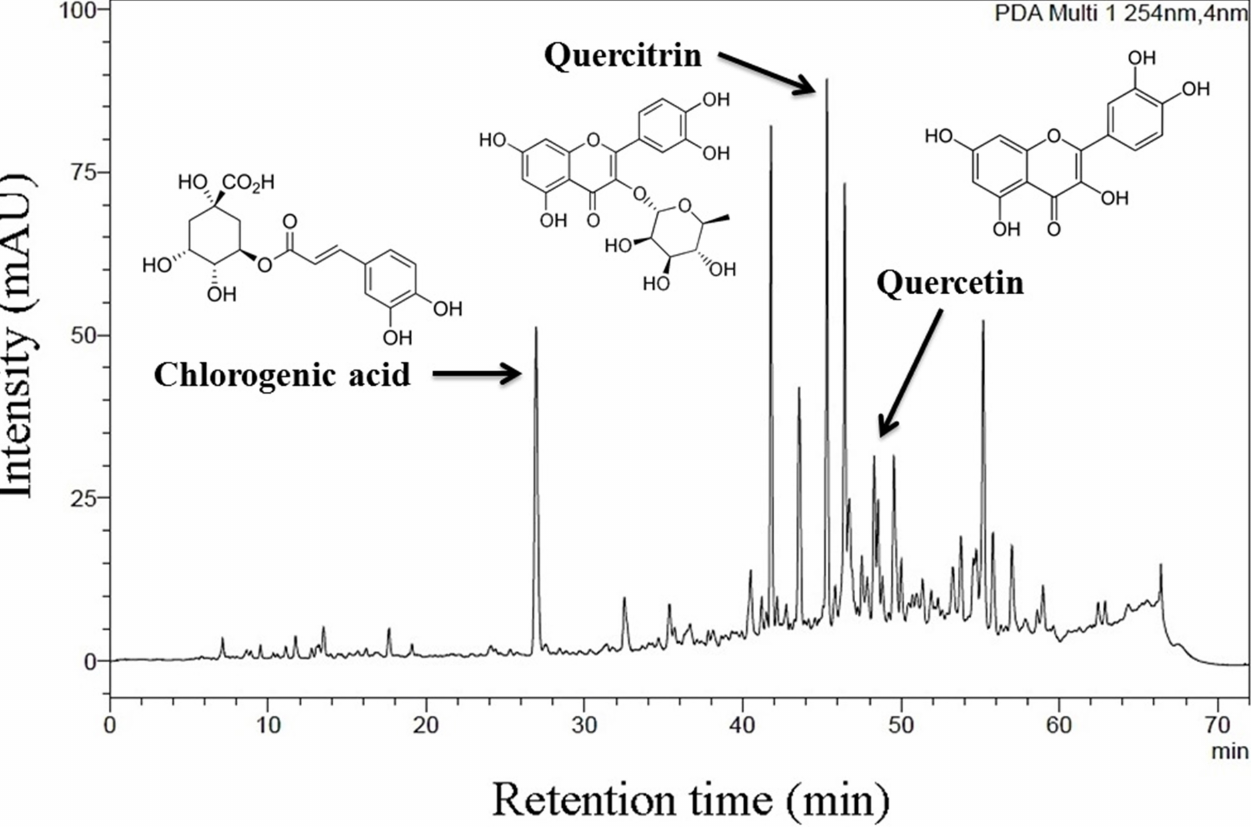
FIGURE 5 - Chromatographic profile of the chloroformic phase of the underground parts of Cyperus iria L. (CFCIUP) at 254 nm